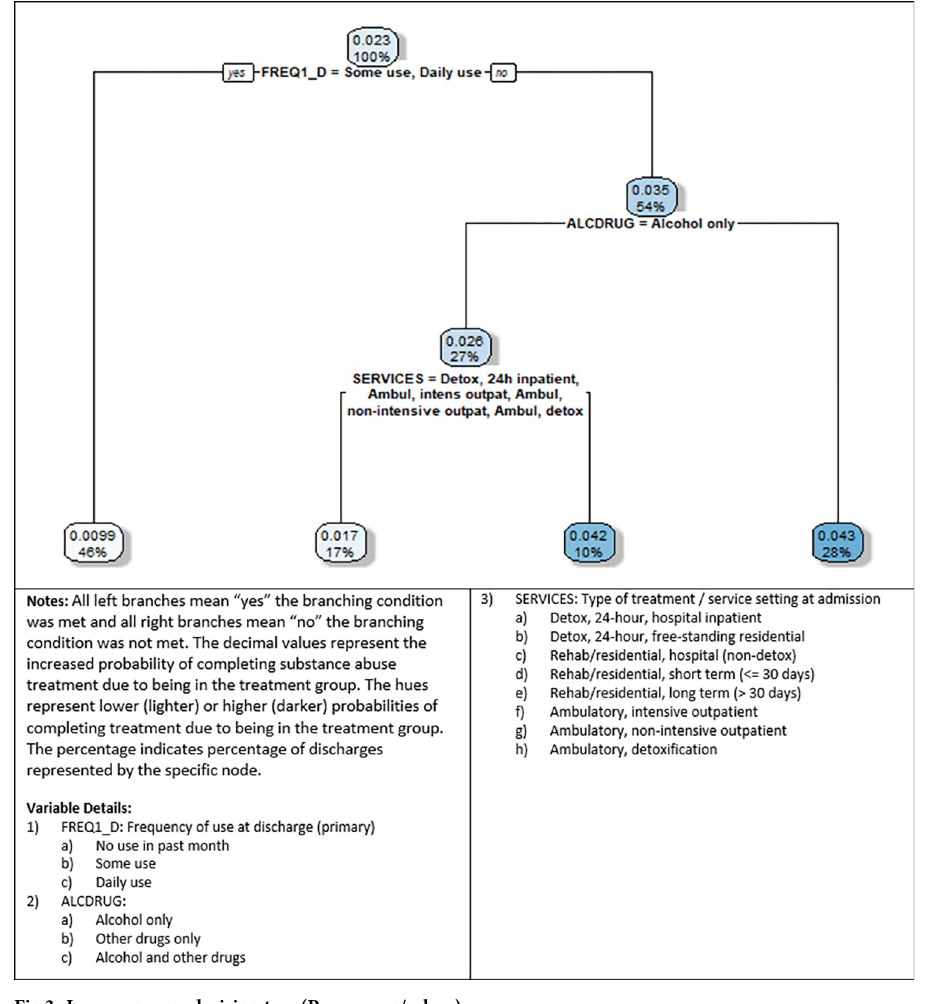
Fig 3. Income source decision tree (P 1i =